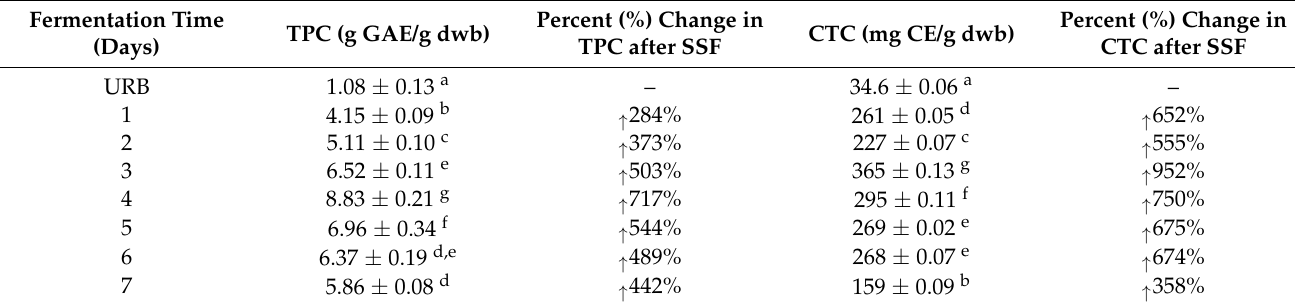
GAE: Gallic acid equivalent; SSF: Solid substrate fermentation; TPC: Total phenolic content; CTC: Condensed tannin content. Means fol- lowed by same superscript within a column do not differ significantly ( p < 0.05). Subscripts show the % increase ( ↑ ) from unfermented sample for corresponding